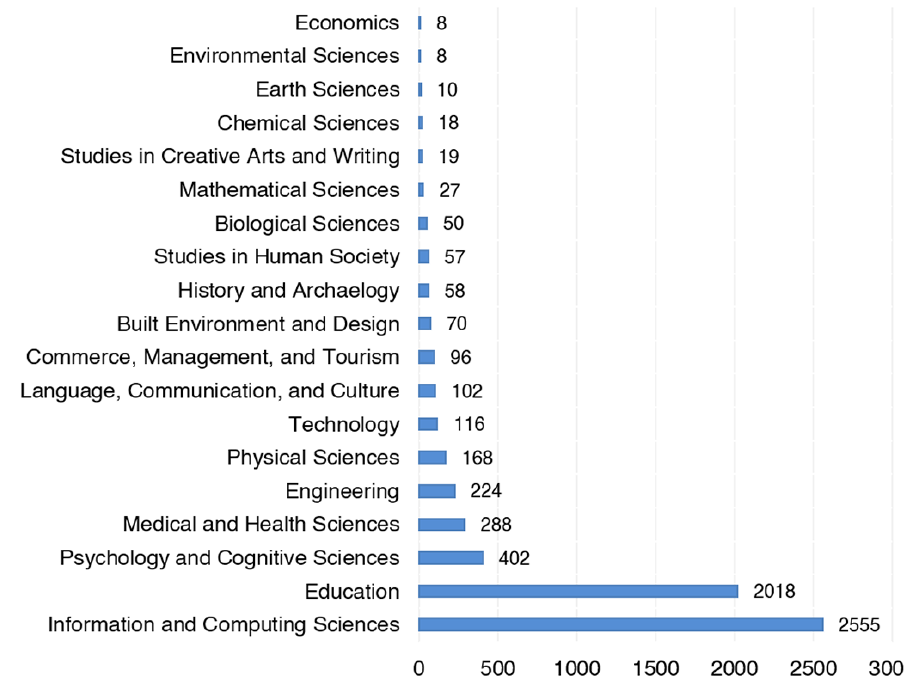
Fig. 9. AR classification by fields of publication